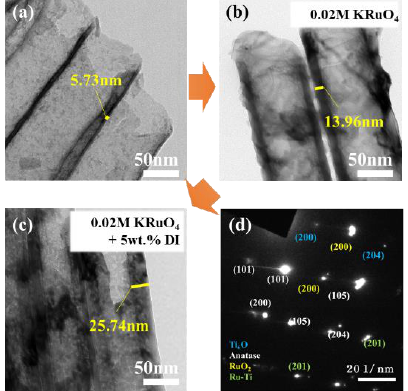
Figure 4. ( a ) TiO 2 nanotubes grown conventionally in ethylene glycol. ( b ) The thickness of the TiO 2 nanotubes is almost doubled by adding RuO 4− (as KRuO 4 ) to the electrolyte during single-step anodization. ( c ) The thickness of the TiO 2 nanotubes doped with RuO 2 is further increased by the addition of water to the RuO 2 precursor-containing electrolyte. ( d ) After doping via single-step anodization, a RuO 2 rutile phase is clearly observed in the TiO 2 anatase phase. Reproduced with permission from ref [17]. WILEY-VCH Verlag GmbH and Co. KGaA, Weinheim (2015).